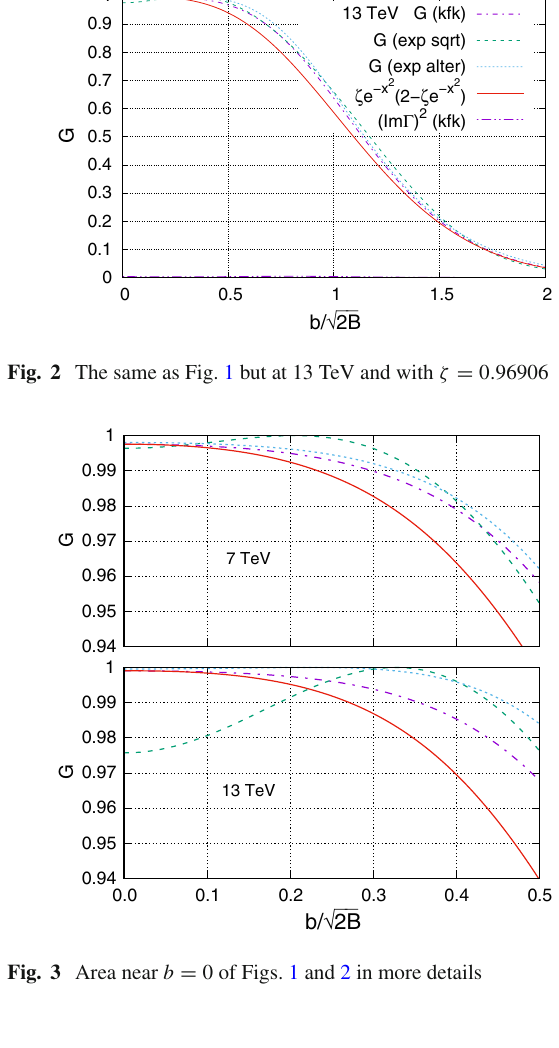
valuesforitsslope B wasextendedtoalltransferredmomenta [12,13] in place of using its experimental form at large | t |